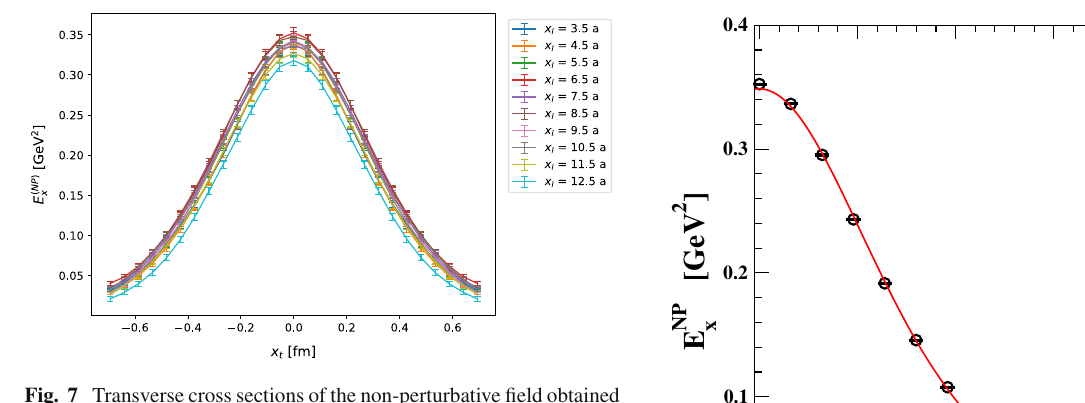
Fig. 7 Transverse cross sections of the non-perturbative field obtained by using the curl procedure E NP x ( x t ) at β = 6 . 370, d = 0 . 85 fm, for several values of x l